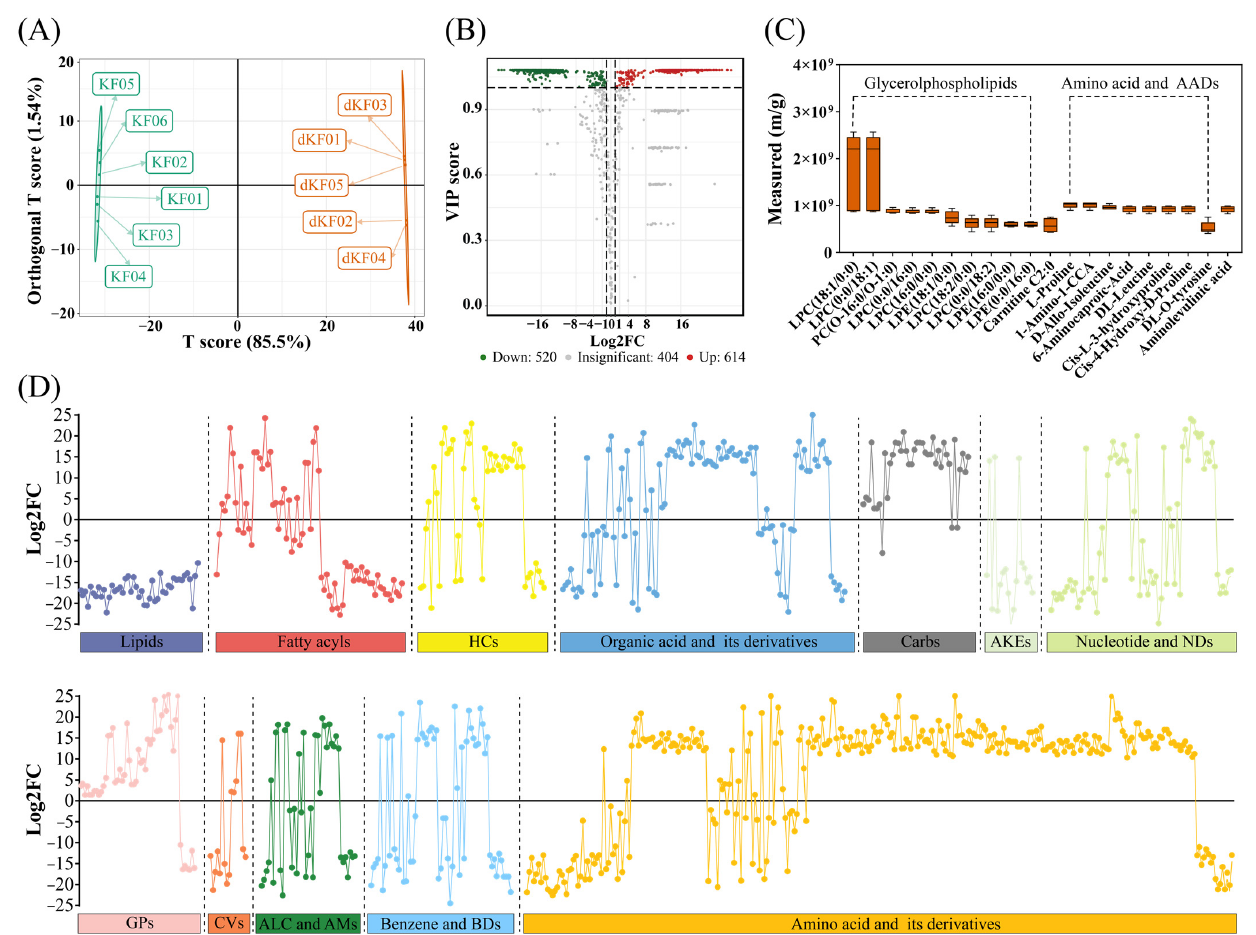
Figure 4. Metabolome analysis between non-diapause (KF) and diapause (dKF) adult females. ( A ) OPLS-DA score plots. ( B ) The distribution of DAMs identified by the cut-off value of VIP ≥ 1 and absolute Log2FC ≥ 1. ( C ) The top 20 metabolites with the highest content at diapause individuals. ( D ) The metabolic profiling of diapausing female adult based on Log 2 FC. The x-axis represents different primary classification of metabolites which differentiated by different